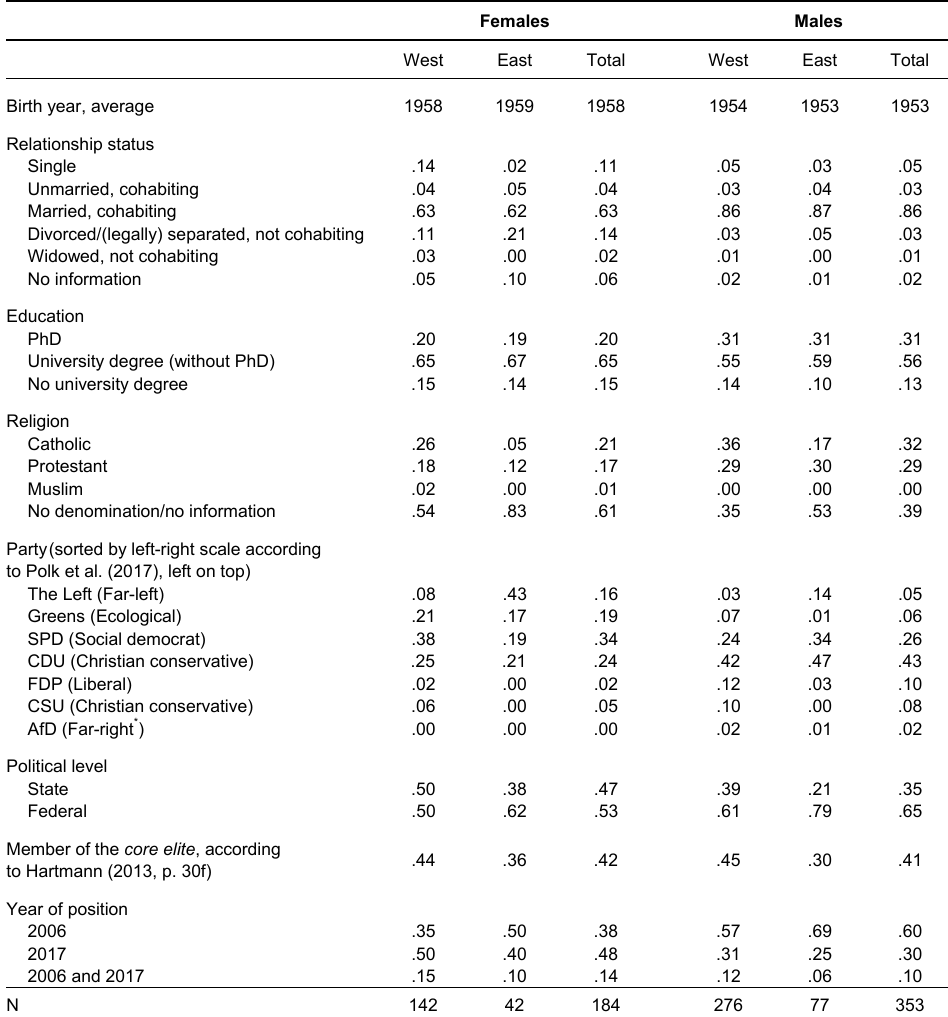
Table 1 : Overview variables for female and male politicians (N=537) Column fractions displayed Females Males West